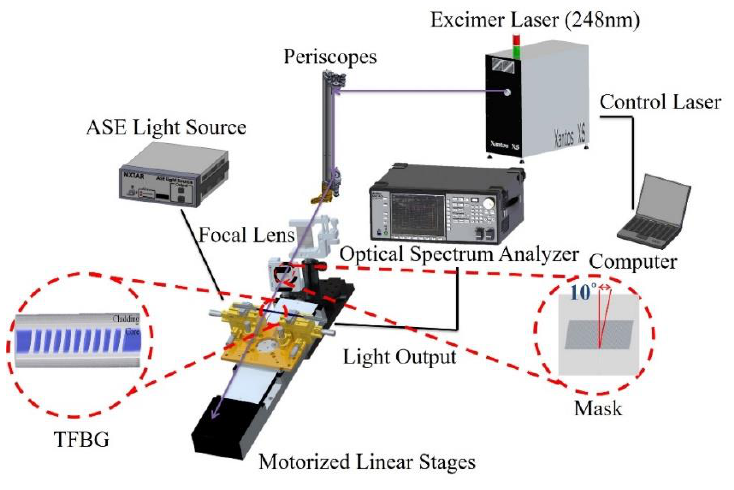
Figure 2. Schematic diagram of the process for TFBG fabrication.